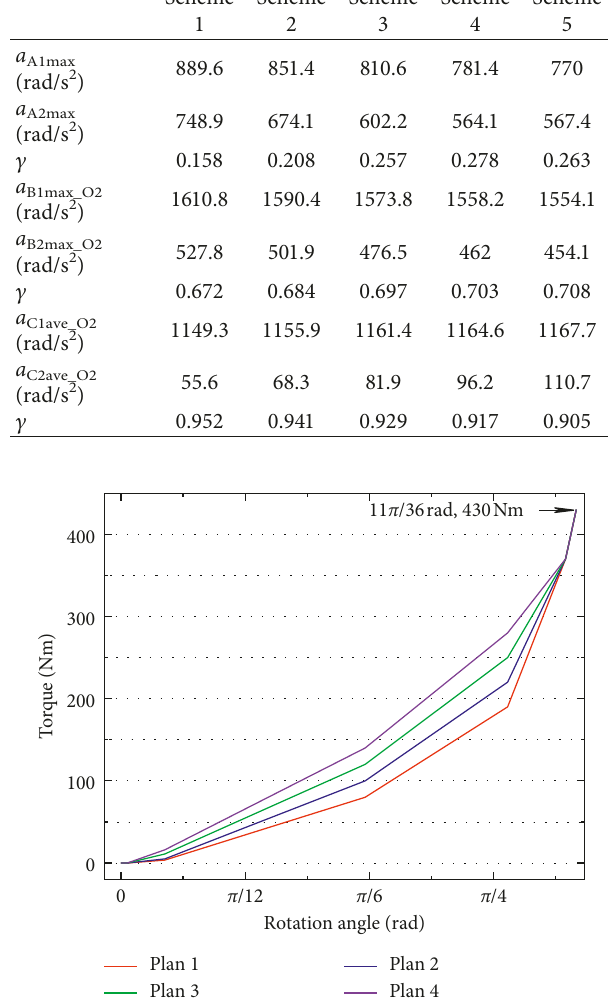
Figure 16: Angular acceleration of different stiffness schemes in Phase A. (a) The primary side result; (b) the secondary side